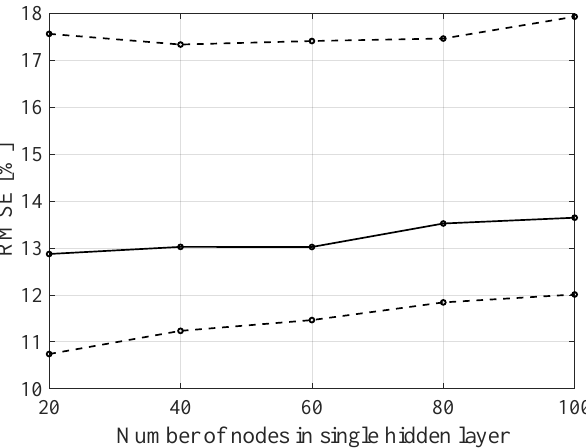
Figure 20. The RMSE BLER as a function of the analyzed time window length (number of the input parameters).